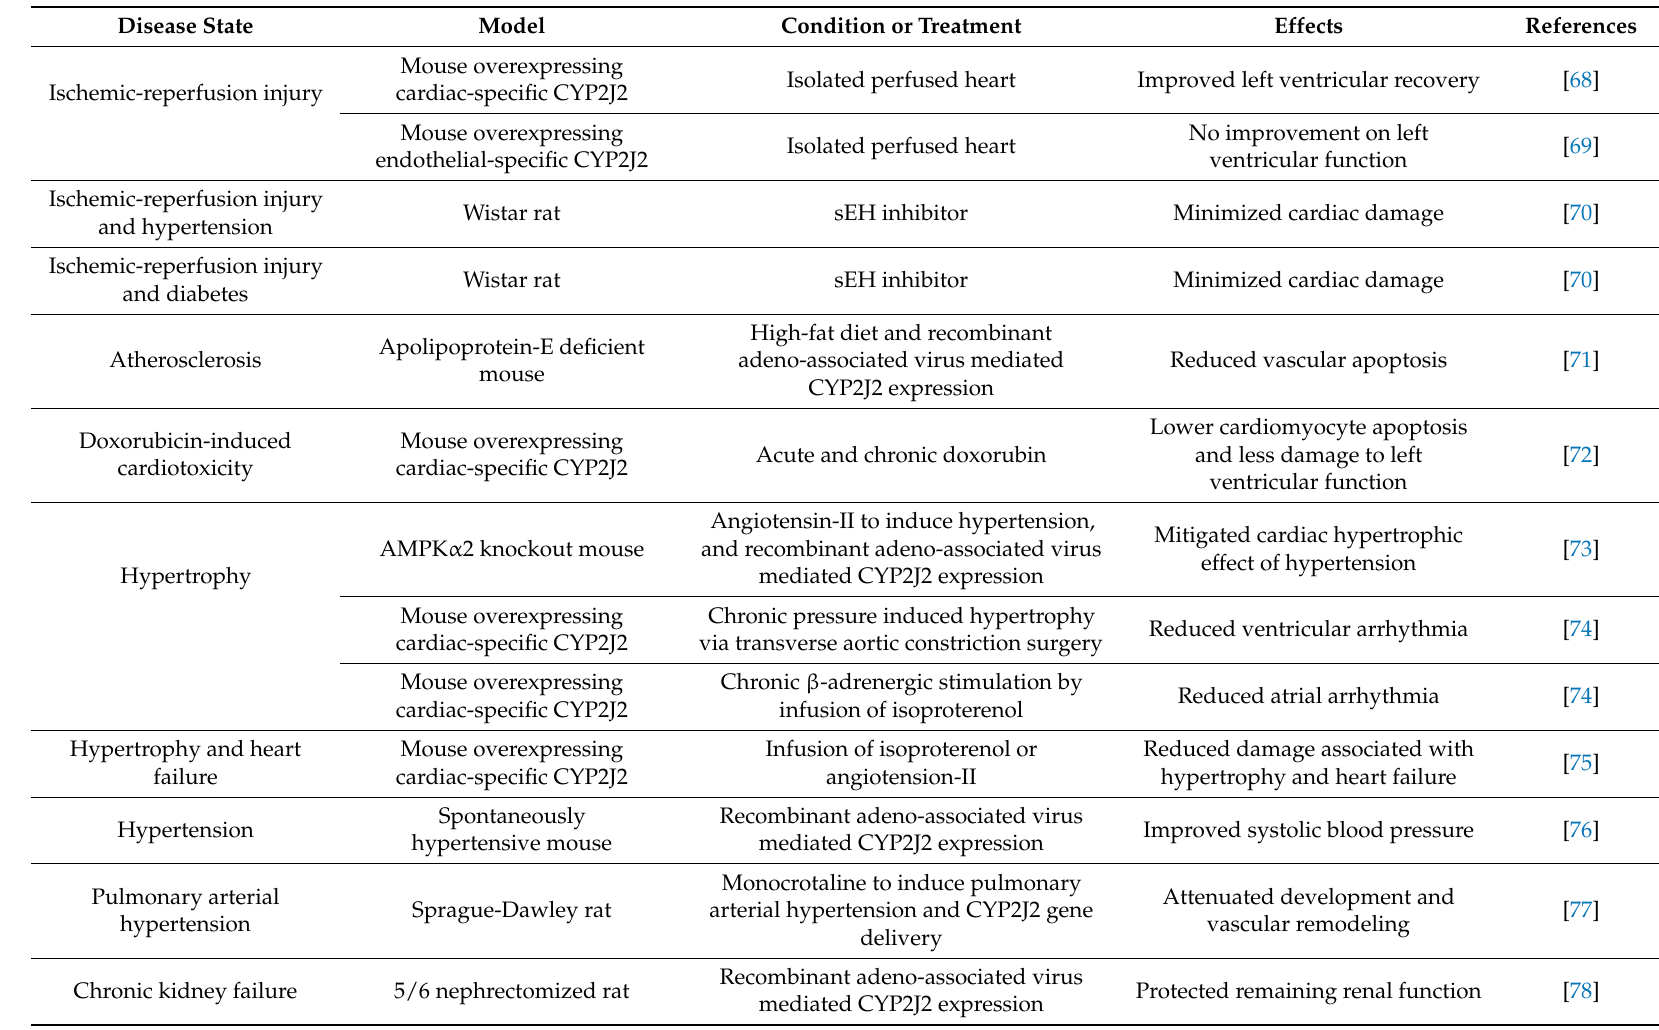
Table 3. The effects of CYP2J2 overexpression on diabetes and cardiovascular disease (CVD) progression and